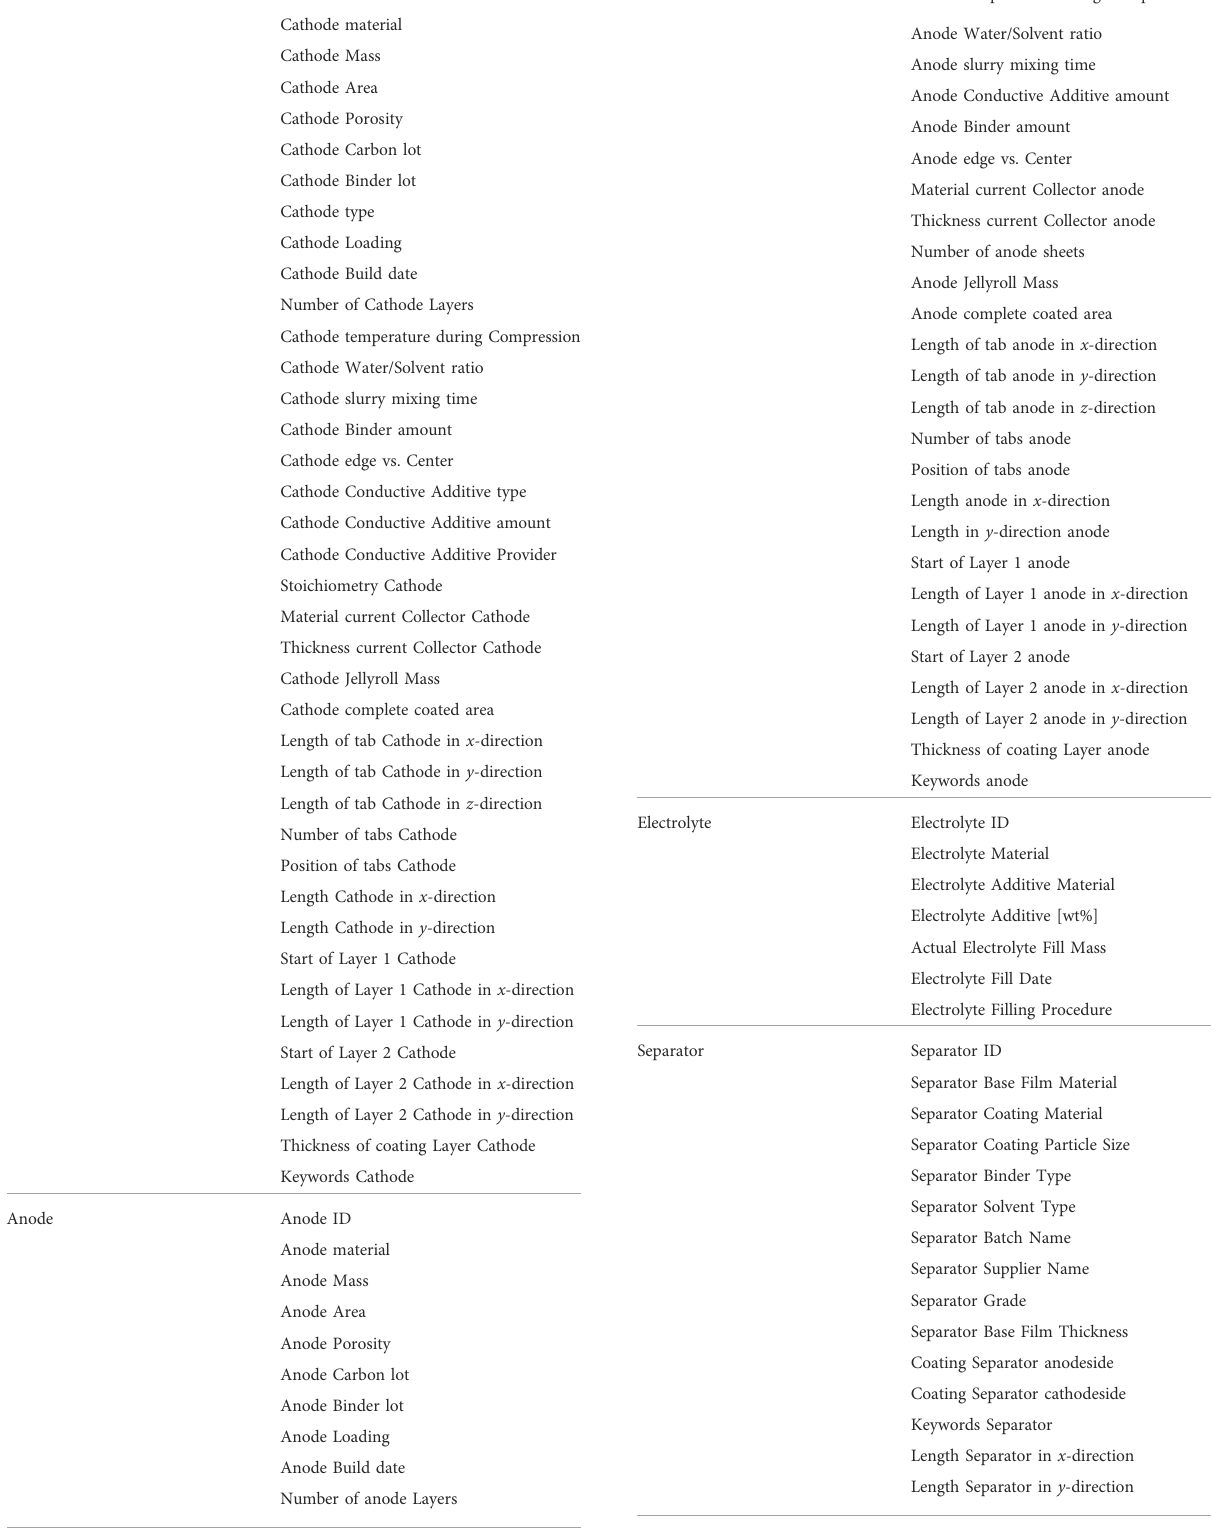
TABLE 4 Metadata to include in designated metadata fi le by cell component.